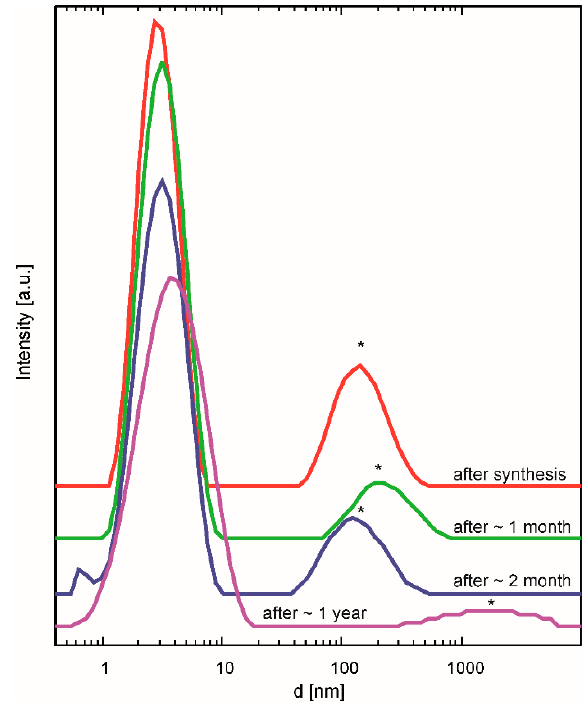
Figure 3. DLS measurements of µE -BZY10 after different times of ageing as indicated. The second peaks marked with asterisks were attributed to apparent agglomerates caused by the concentration.